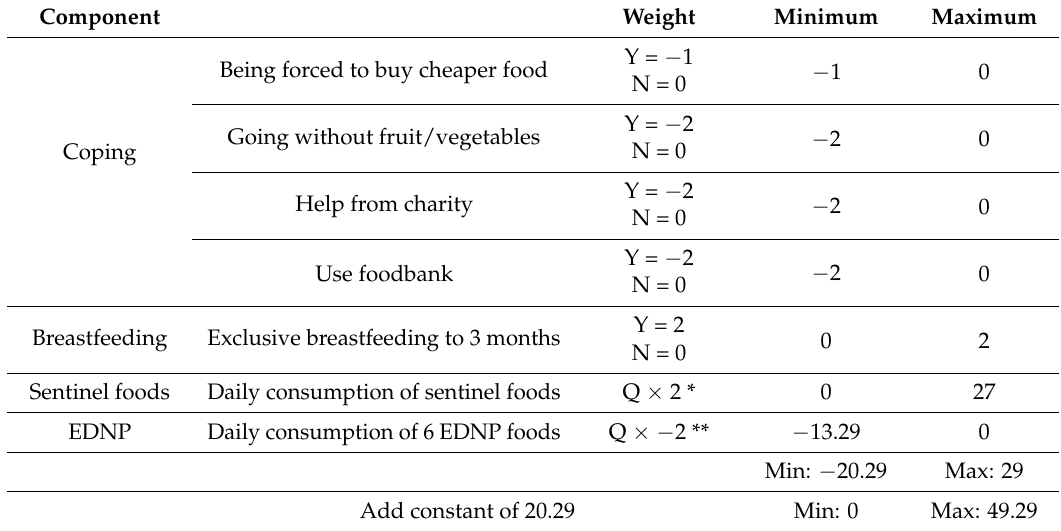
Table 2. Food security index components, weights, scores, and